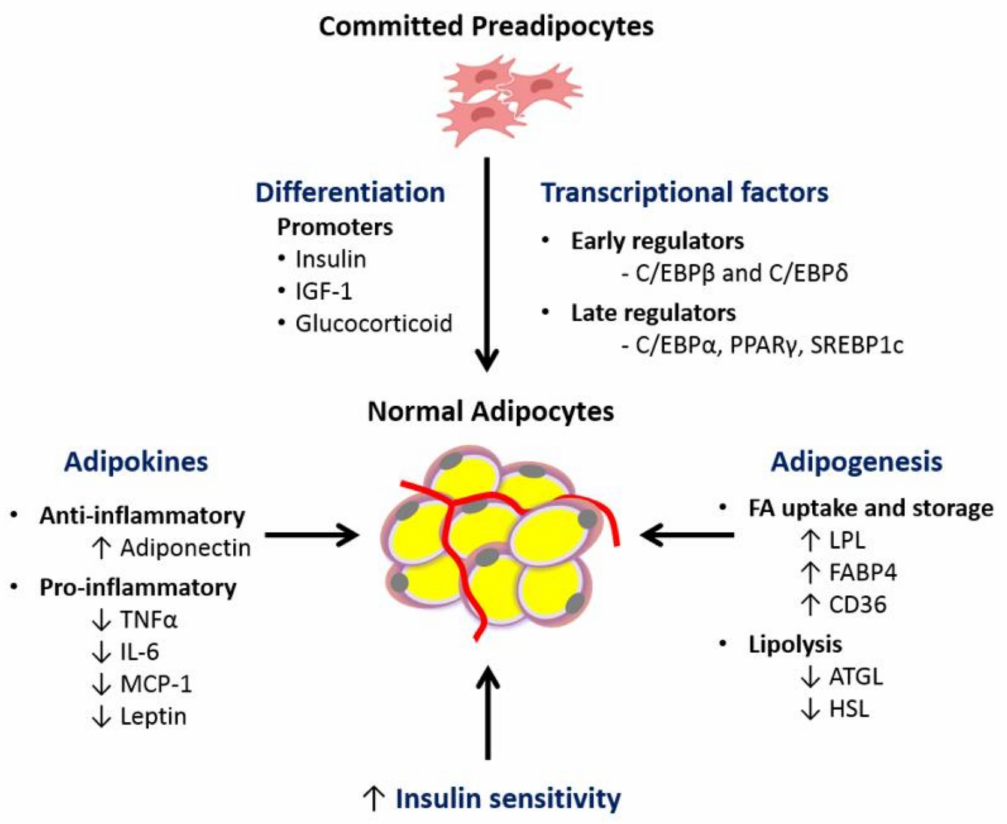
Figure 1. Key transcription factors involved in di ff erentiation of pre-adipocytes to adipocytes that underpin healthy adipocytes. Factors such as insulin, IGF and glucocorticoids can induce di ff erentiation of committed fibroblast-like preadipocytes into spherical adipocytes capable of storing TG within lipid droplets in the cell. Hormonal stimulation triggers di ff erentiation by the expression of early di ff erentiation factors C / EBP- β / δ and late transcription factors C / EBP- α , PPAR- γ and SREBP-1c. PPAR- γ is known as the main regulator of adipogenesis and modulates the expression of various genes associated with fatty acid uptake, storage, lipolysis and adipokines. (IGF, insulin-like growth factor; C / EBP, CCAAT / enhancer binding protein; PPAR- γ , peroxisomal proliferator-activated receptor gamma; SREBP, Sterol regulatory-element binding protein; FA, fatty acid; TNF- α , tumor necrosis factor alpha; IL-6, interleukin 6; MCP-1, monocyte chemoattractant protein-1; LPL, lipoprotein lipase; FABP4, fatty acid binding protein 4; ATGL, adipose triglyceride lipase; HSL, hormone sensitive